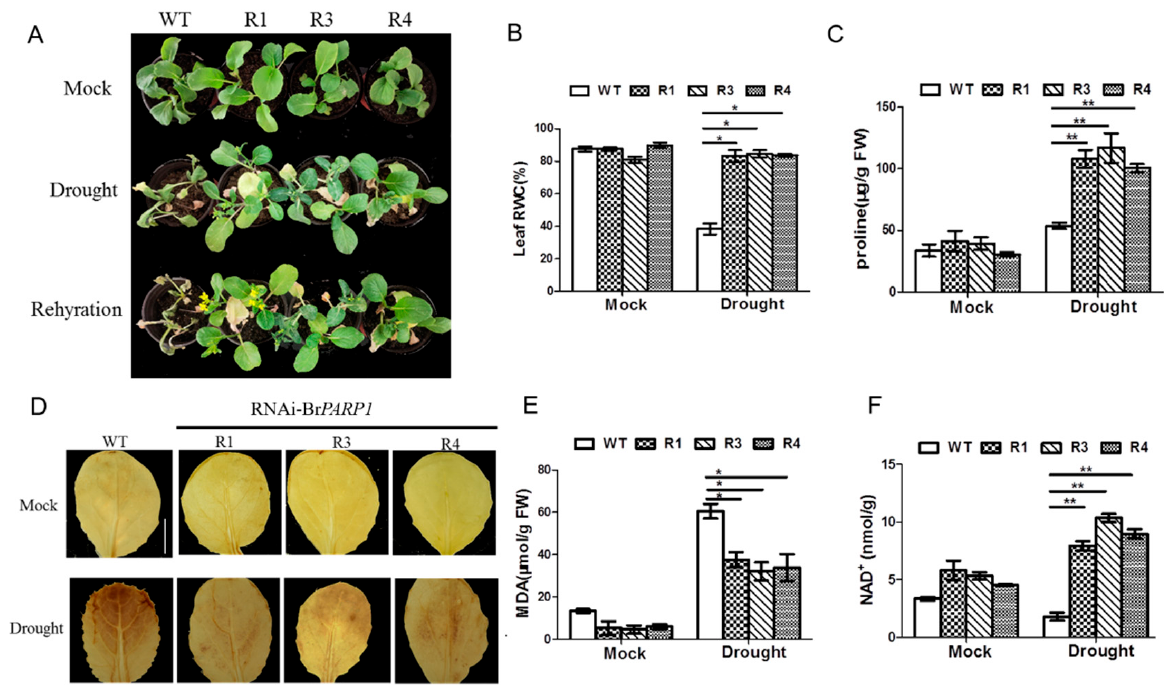
Figure 3. ( A ) Phenotype analysis of WT and RNAi-Br PARP1 during dehydration treatment. Three RNAi-BrPARP1 transgenic lines and WT were treated with withholding irrigation at the seedling stage for about 3 weeks. ( B ) Relative water content of detached leaves of RNAi-Br PARP1 and WT plants. ( C ) Proline content of RNAi-Br PARP1 and WT plants under normal conditions and after water deprivation. ( D ) ROS content of RNAi-Br PARP1 and WT plants. ( E ) MDA content of RNAi-Br PARP1 and WT plants under normal conditions and after water shortage. ( F ) NAD+ content of RNAi-Br PARP1 and WT plants under normal conditions and after water shortage. Values were means ± se of biological replicates ( n > 3). (** p < 0.01, * p < 0.05).